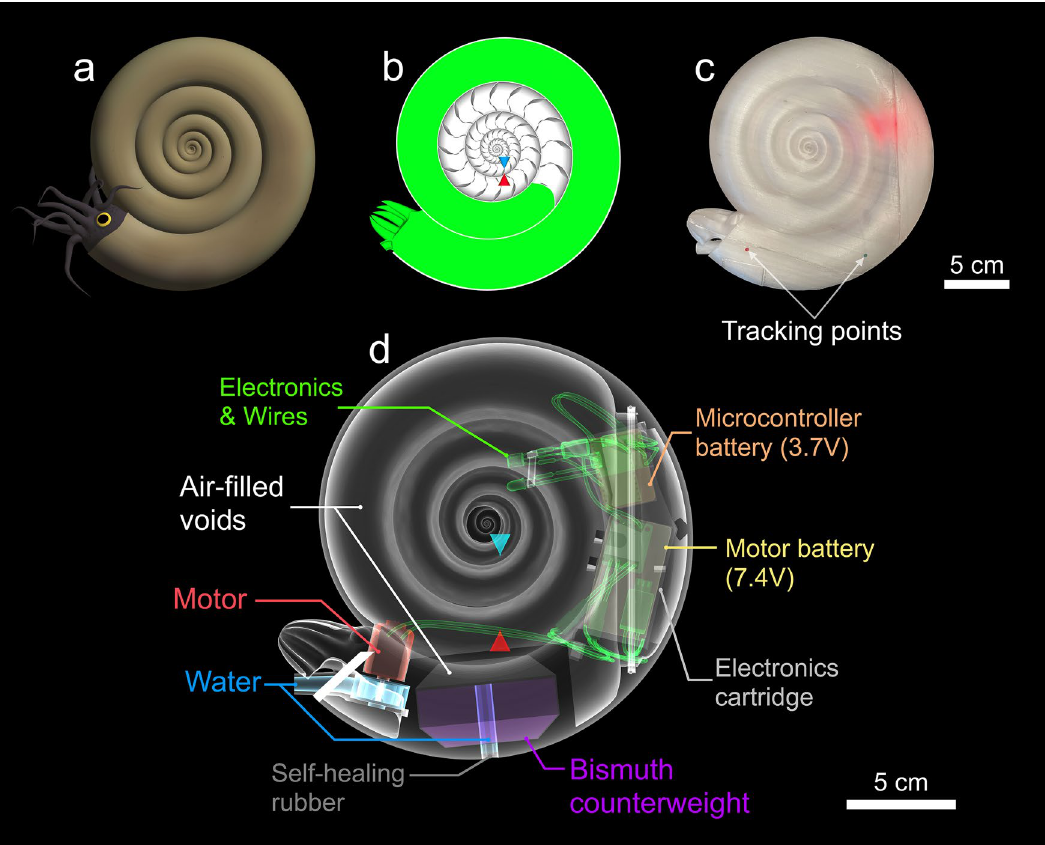
Figure 1. Biomimetic cephalopod robot design. ( a ) Hypothetical reconstruction of an ectocochleate cephalopod. ( b ) Virtual model used to determine the hydrostatic properties of this particular shape (serpenticone; see “Methods”). ( c ) Fully assembled 3D-printed robot with tracking points used in “3D motion tracking”. ( d ) Schematic of the assembled robot indicating each model component (color-coded by measured bulk density values; Table S1). The tips of the blue and red cones denote the locations of the centers of buoyancy and mass, respectively. All models were rendered in MeshLab 76